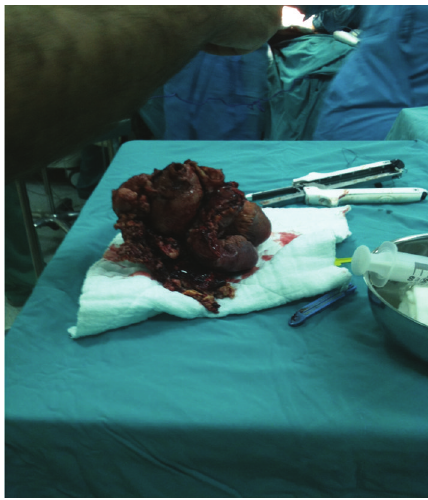
Figure 4: Macroscopic view of the mass resected from the terminal ileum after